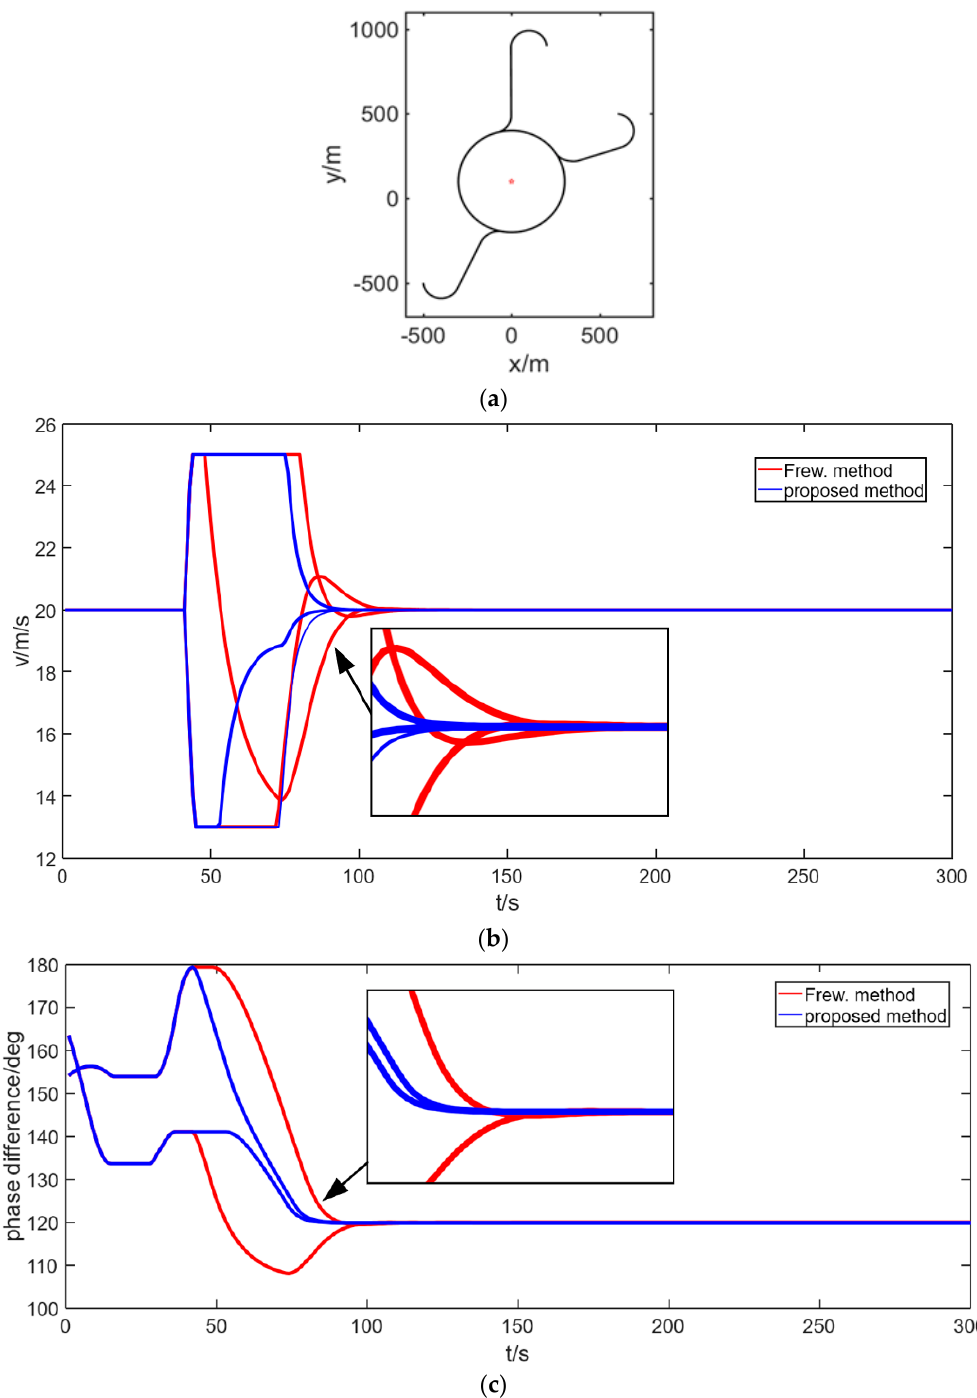
Figure 15. Experiments results of phase keeping. ( a ) Trajectories of three UAVs; ( b ) Curves of velocity versus time; ( c ) Curves of phase difference versus time.